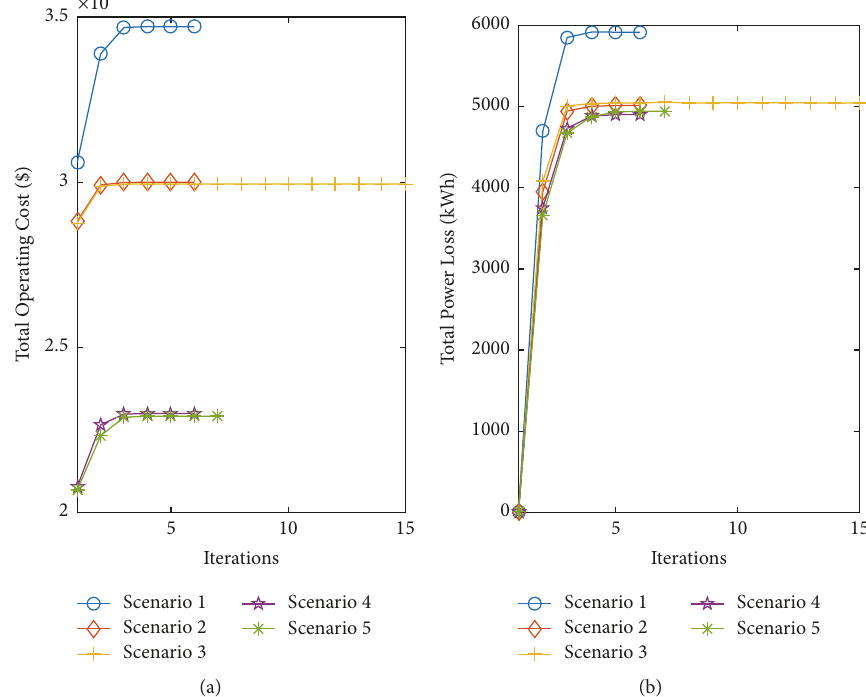
Figure 10: Evolution of (a) total operating cost and (b) total power loss over 24 hours.